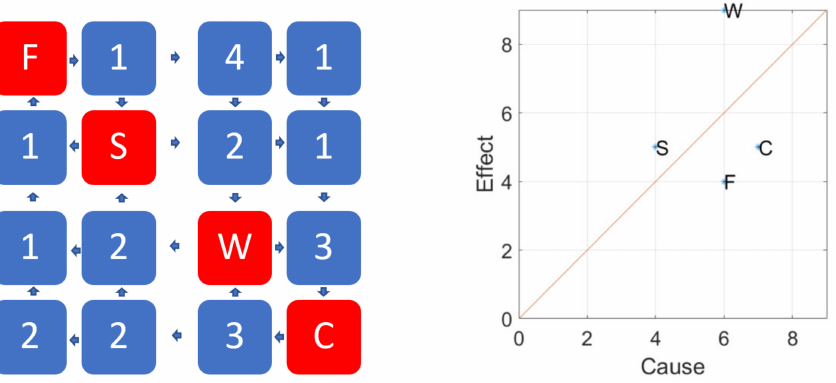
Figure 3. The rock engineering system approach to derive parameter interaction intensity and importance for the problem shown in Figure 2. Figures modified from